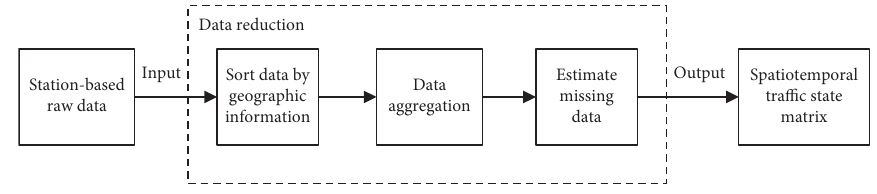
Figure 3: Data reduction of INRIX probe data.